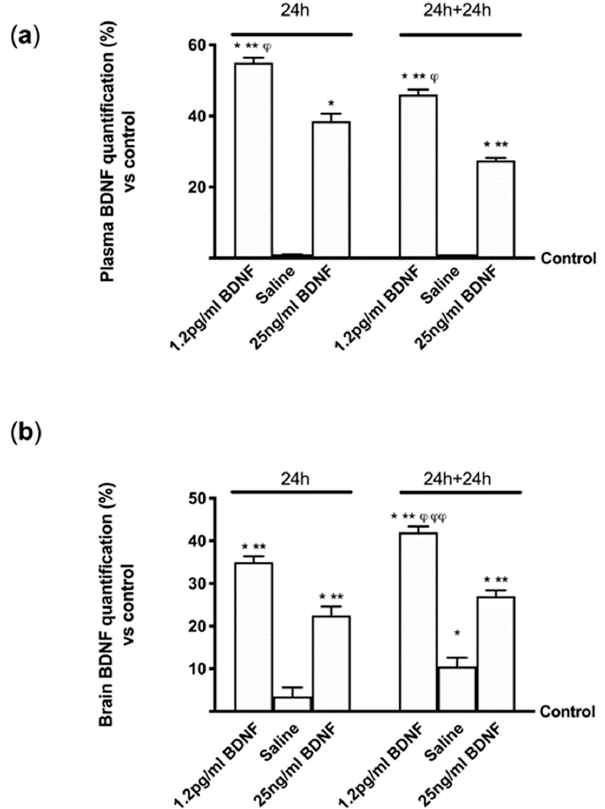
Figure 8. BDNF quantification in mice in serum and brain tissue. ( a ) Serum quantification and ( b ) BDNF quantification in brain tissue are reported. Each graph contains on the left the results obtained at 24h (12 animals) and on the right (12 animals) at 24 h plus 24 h (24 h + 24 h). Data are expressed as means ±SD (%) normalized to control (0 line as control). * p < 0.05 vs control; ** p < 0.05 vs saline solution; 𝜑 p < 0.05 vs the same treatments in the same time of administration; 𝜑𝜑 p < 0.05 vs the same treatments at 24 h and 24 h plus 24 h.